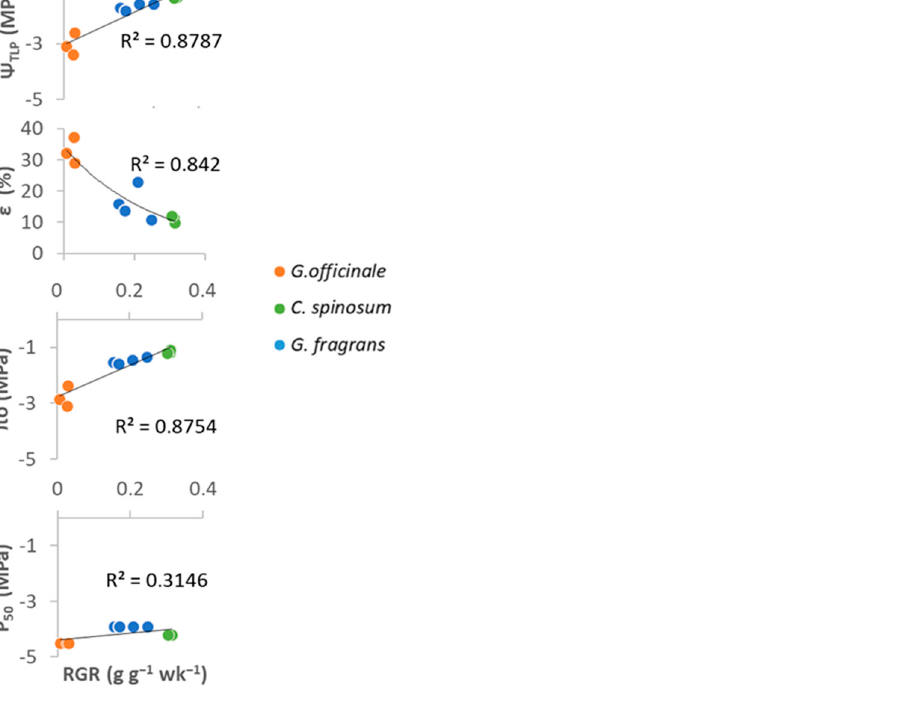
Figure 9. Relationships between relative growth rate (RGR) and four drought tolerance traits in seedlings of the three species studied (four individuals per species).